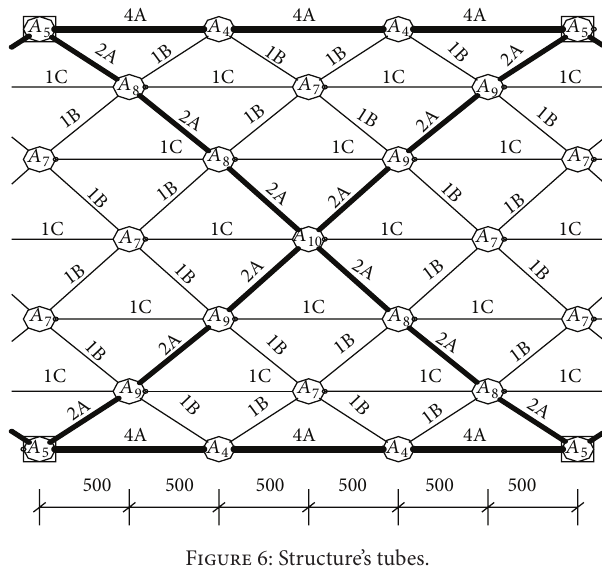
Figure 6: Structure’s tubes.